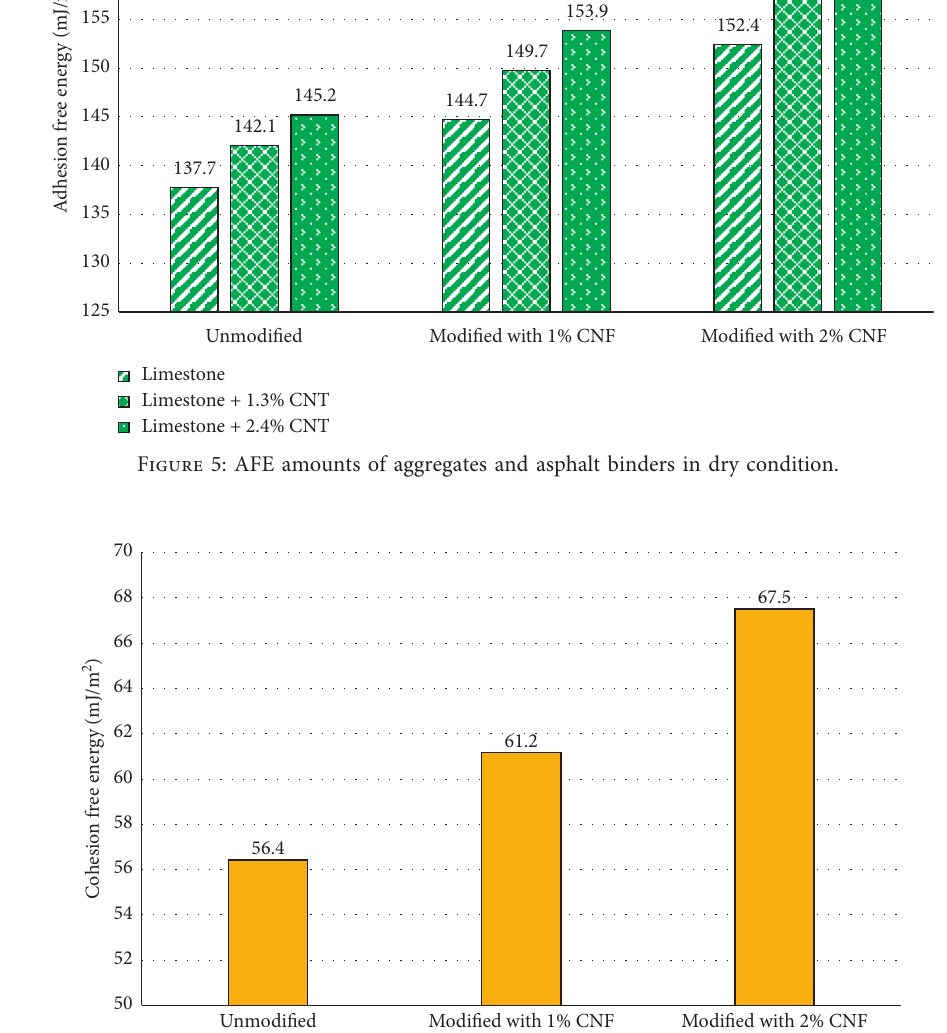
Figure 6: CFE values of base and modified asphalt